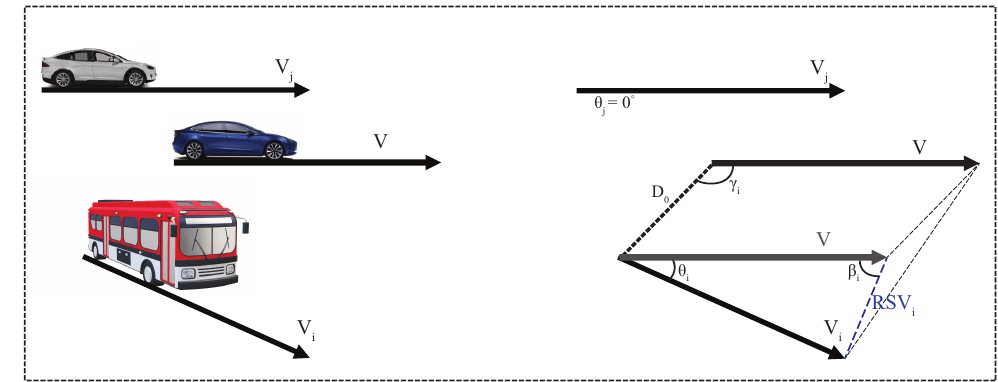
Figure 4. Graphical representation of vehicles moving at different velocities and